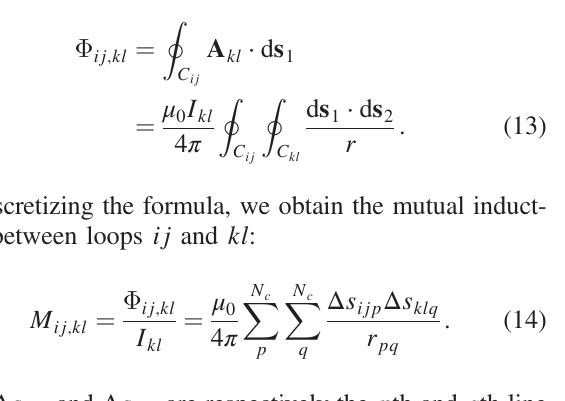
TABLE III. Examples of values of B 0 and the corresponding values of Δ B required to obtain each B 0 (analytical, B 0 =B 0 s has an error of 2% in the range 0 . 1 ≤ g= λ